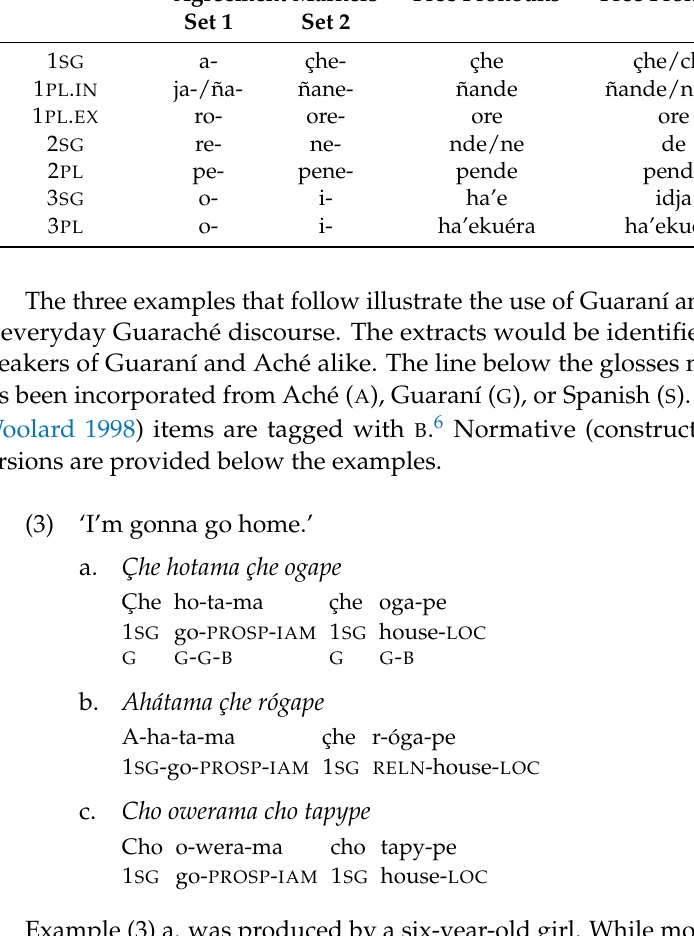
Agreement Markers Free Pronouns Free Pronouns Free Pronouns Set 1 Set